Question: Condense the content of this figure into a single sentence.
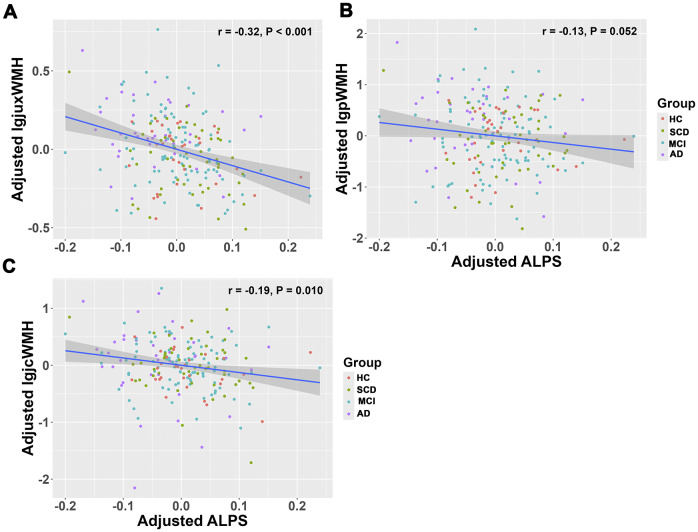
Answer: Association between ALPS and white matter hyperintensities in different regions. After adjusting for gender, age, education level, and APOE4 as covariates, ALPS showed significant negative correlations with lgjuxWMH and lgjcWMH ( r = −0.32, P < 0.001; r = −0.19, P = 0.010); the correlation between ALPS and lgpWMH approached statistical significance ( r = −0.13, P = 0.052). Note: ALPS, ‘Analysis of diffusion tensor imaging along the perivascular space’; HC, ‘Healthy Controls’; SCD, ‘Subjective Cognitive Decline’; MCI, ‘Mild Cognitive Impairment’; AD, ‘Alzheimer’s Disease’; juxWMH, ‘juxtaventricular white matter hyperintensities’; pWMH, ‘periventricular white matter hyperintensities’; jcWMH, ‘juxtacortical white matter hyperintensities’. Figure 4. long description.